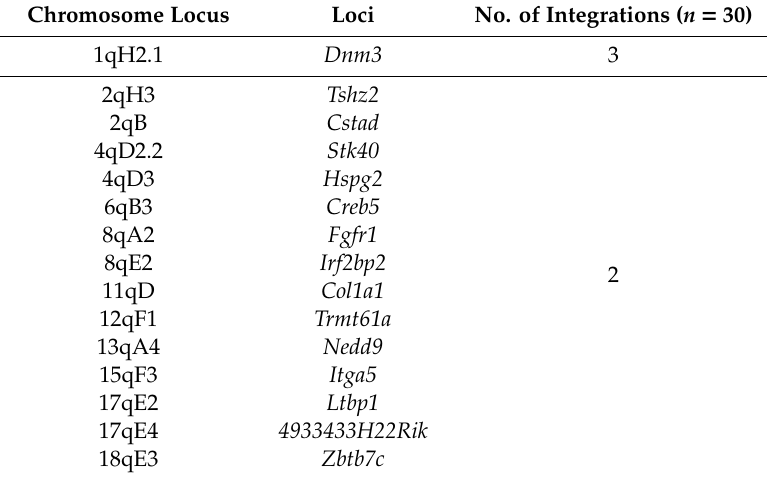
Table 1. Common retroviral integration sites in murine synovial sarcoma. Chromosome Locus Loci No. of Integrations ( n =